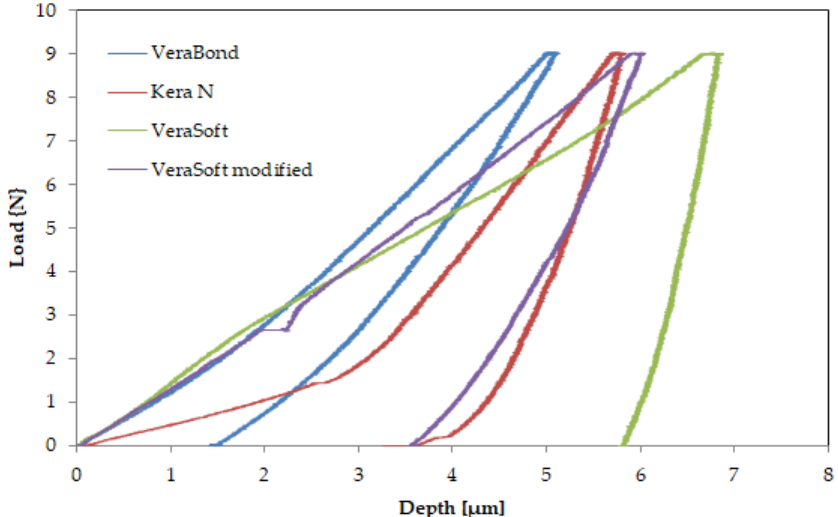
Figure 6. Indentation curves of the studied alloys: a) VeraBond, b) Kera N, c) VeraSoft, d) VeraSoft modified.